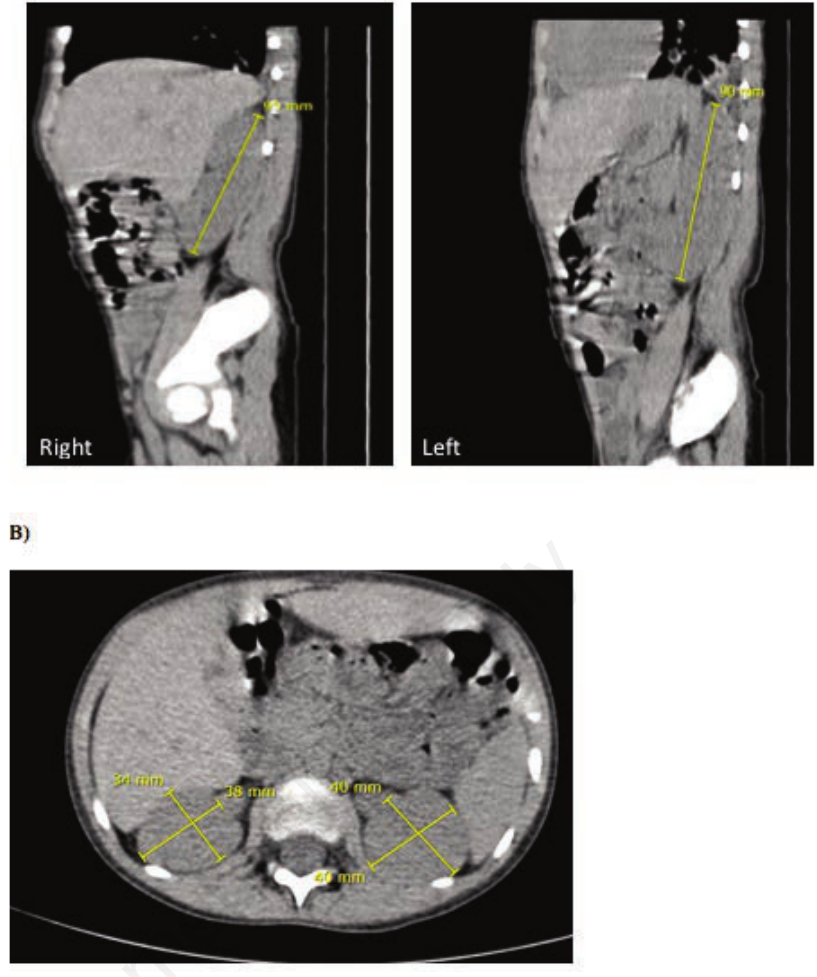
Figure 1. Computed tomography of the abdomen. Panel A: right and left kidney longi- tudinal diameters - Panel B: transversal diameters.